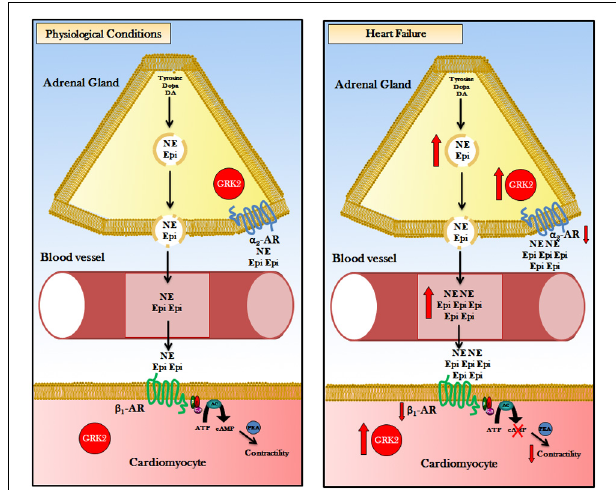
FIGURE 1 | Representation of the pathophysiologic role of GRK2 in adrenal CA-production/secretion: Body’s major source of CAs is the adrenal medulla, the central part of the adrenal gland, where the chromaffin cells secrete approximately 20% NEpi and 80% Epi. Physiological conditions: G-protein-coupled receptor kinase 2 (GRK2) regulates ARs: (1) in chromaffin cell of adrenal gland GRK2 phosphorylate α 2ARs that exert a tonic sympathoinhibitory function. (2) in cardiomyocytes GRK2 phosphorylate β 1-AR regulate cardiac contractility by AC-PKA pathway activation. Heart Failure: G-protein-coupled receptor kinase 2 (GRK2) is upregulated in chromaffin cell and in cardiac myocyte. In the adrenal chromaffin cell, augmented GRK2 levels determinate an hyper-phosphorylation and desensitization of α 2ARs, causing increased levels of Epi/NE production and secretion. Increasing in amounts of circulating CAs led to hyper-stimulation of β 1-AR and GRK2 overactivation. Cardiac GRK2 upregulation results in phosphorylation and desensitization/downregulation of β 1-ARs leading to reduction of contractility. Consequently, double inhibition of GRK2 (pharmacological or gene therapy) in the heart and in the adrenal gland could have impressive therapeutic effect in heart failure enhancing cardiac contractility and reducing plasmatic CAs levels. Acronyms: CAs, Catecholamines; DA, Dopamine; NE, Norepinephrine; Epi, Epinephrine; GRK2, G protein-coupled Receptor Kinase 2; ARs, Adrenergic Receptor; α 2-AR, α 2-Adrenergic Receptor; β 1-AR, β 1-Adrenergic Receptor; ATP, Adenosine Tri-Phosphate; AC, Adenylyl Cyclase; cAMP, cyclic Adenosine Mono-Phosphate; PKA, Protein Kinase